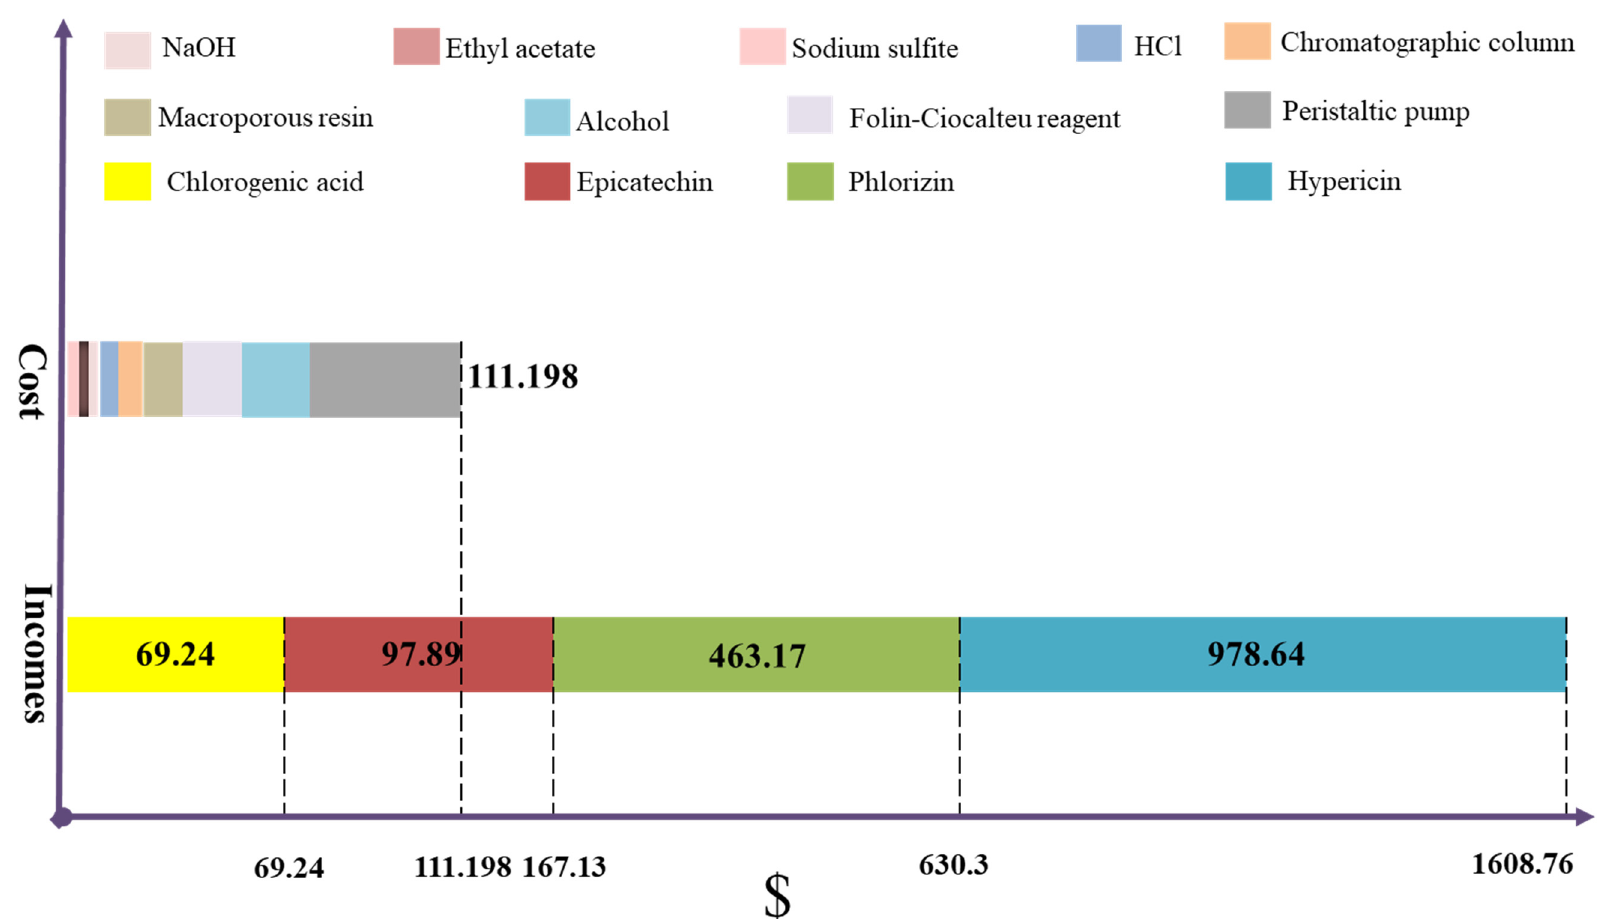
Figure 6. Costs and incomes produced from the extraction of monomeric phenols from thinned fruits.